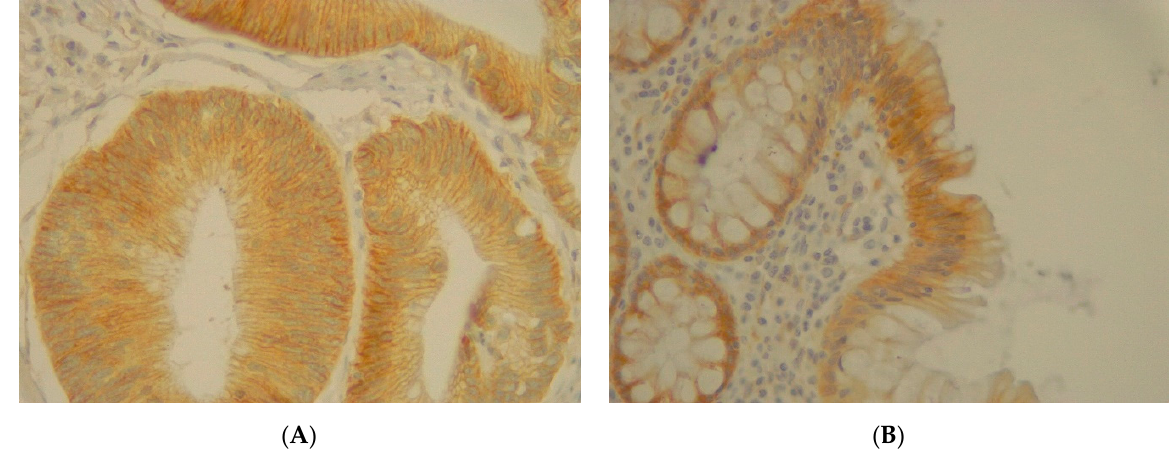
Figure 9. ( A ) Immunohistochemical staining of VANGL1 in colorectal adenocarcinoma with an intensity score of 3+ with more than 70% of the stained cells. ( B ) Immunohistochemical staining of VANGL1 in normal sample.